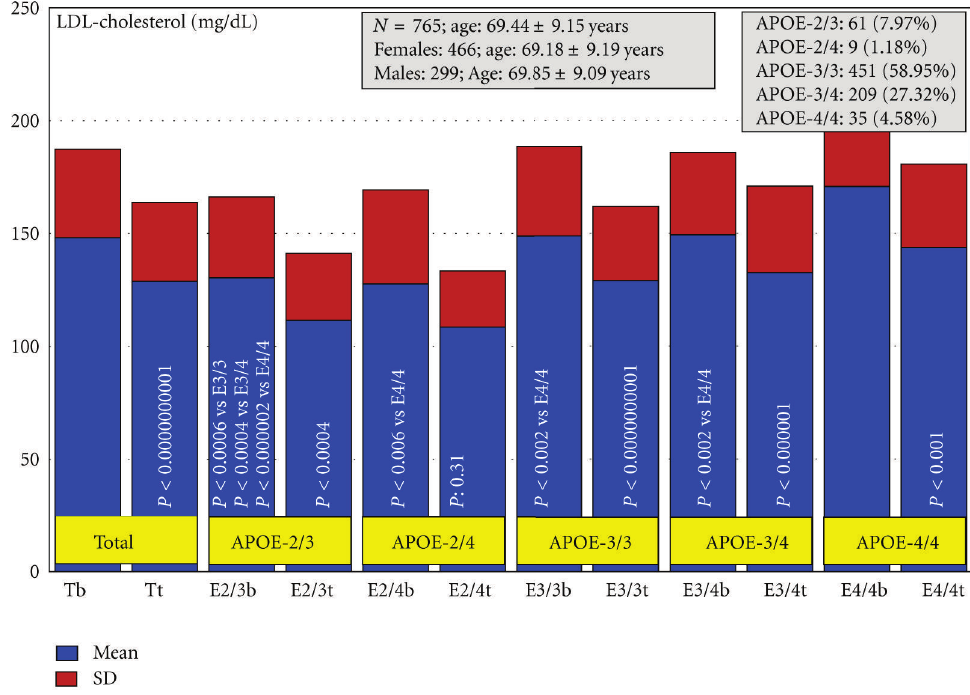
Figure 5: APOE -related changes in LDL-cholesterol levels in patients with dementia treated with E-SAR-94010. Tb: basal LDL-cholesterol (LDL-CHO) levels prior to treatment; Tt: LDL-CHO levels after 3 months of treatment in the total sample. E2/3b: basal LDL-CHO levels in APOE-2/3 carriers; E2/3t: LDL-CHO levels after treatment in APOE-2/3 carriers; E2/4b: basal LDL-CHO levels in APOE-2/4 carriers; E2/4t: LDL-CHO levels after treatment in APOE-2/4 carriers; E3/3b: basal LDL-CHO levels in APOE-3/3 carriers; E3/3t: LDL-CHO levels after treatment in APOE-3/3 carriers; E3/4b: basal LDL-CHO levels in APOE-3/4 carriers; E3/4t: LDL-CHO levels after treatment in APOE-3/4 carriers; E4/4b: basal LDL-CHO levels in APOE-4/4 carriers; E4/4: LDL-CHO levels after treatment in APOE-4/4